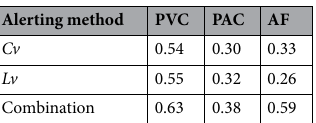
Table 1. MCC values measuring the performances of each alerting method.